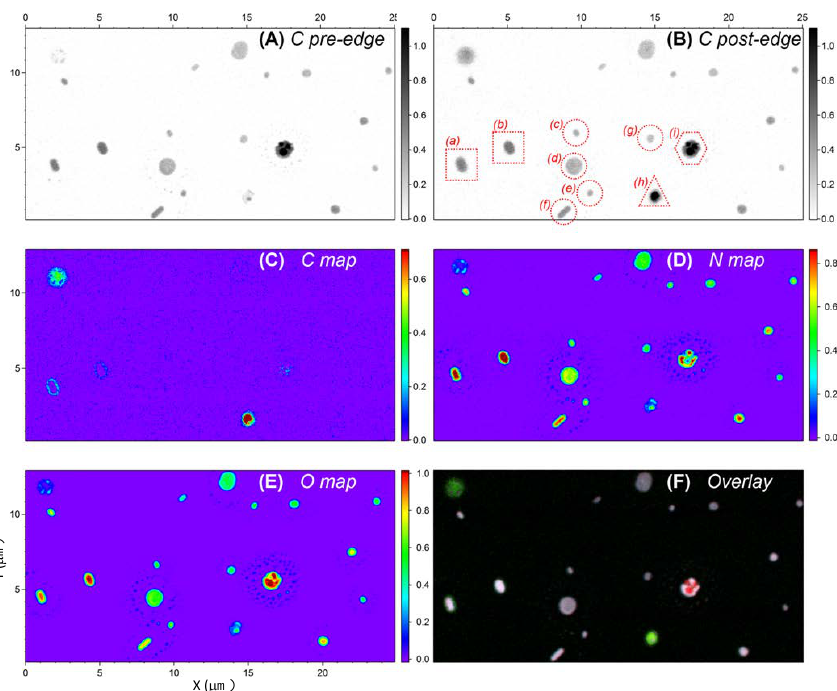
Figure 5. STXM images and elemental maps of representative accumulation mode particles in the ZOTTO aerosol samples. The particles shown here represent a volume equivalent diameter range of 0.3–0.6µm. (Panels a and b ): carbon pre- and post-edge images; panel (c) : carbon elemental map; panel (d) : nitrogen map; panel (e) : oxygen map; and panel (f) : overlay of C (green), N (blue), and O (red) maps. Axes in panels (a) – (e) display image dimensions in µm. Optical density (color code) is displayed for individual maps. Red boxes and labels in panel (b) exemplify the most common particle types in STXM samples: (a) and (b) show internally mixed particles with ammoniated sulfate core and organic coating; (c) – (g) show mostly purely inorganic ammoniated sulfate particles; (i) shows ammoniated sulfate with potassium; and (h) shows a C-rich particle with small inorganic